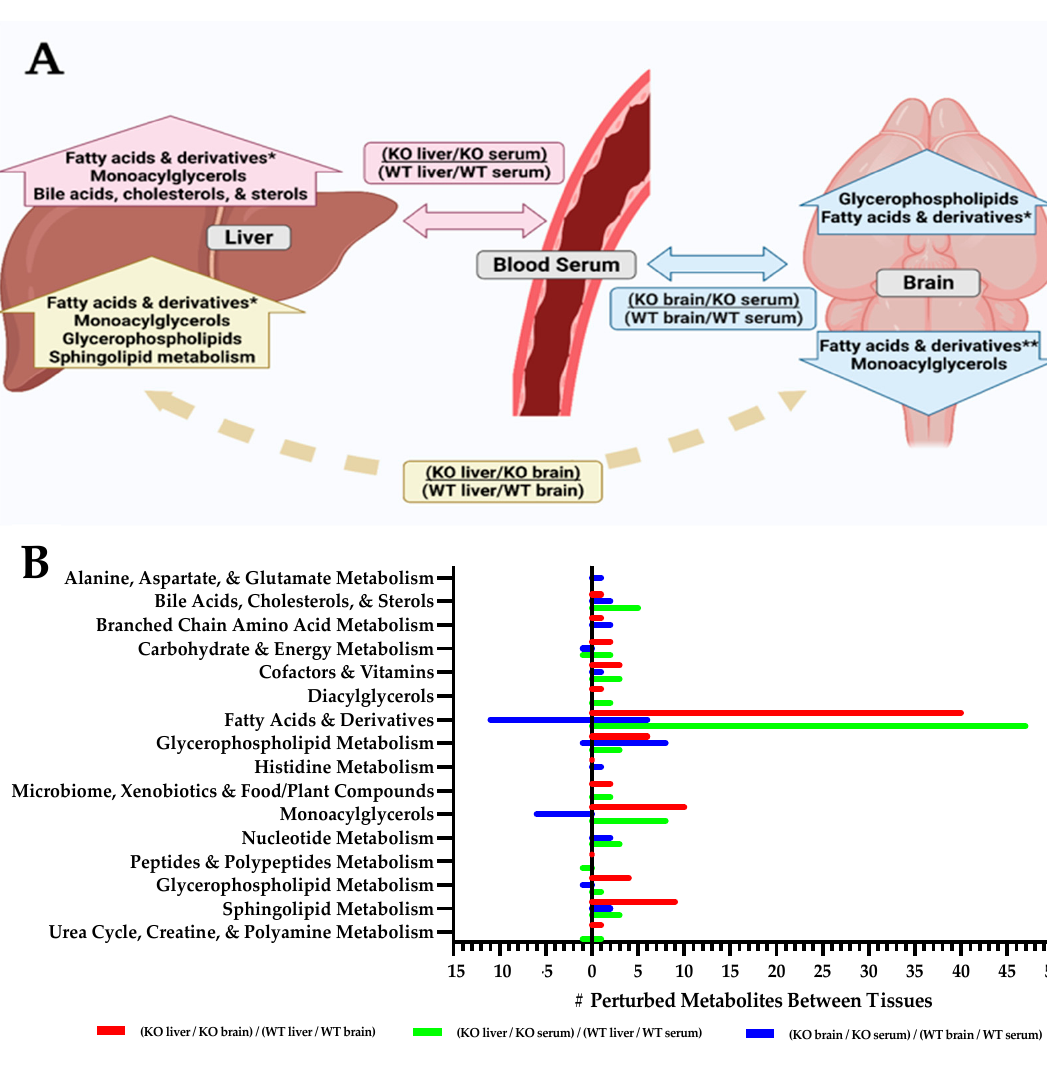
Figure 3. Metabolite flux between tissues is altered in Slc13a5 deficiency mice. ( A ) A model of the flow of metabolites between tissues in Slc13a5 − / − mice is shown. Horizontal arrows indicate the metabolite ratios assessed to understand the change in flux, storage, synthesis, or breakdown of metabolites between Slc13a5 − / − and WT mice. Mice included for each tissue type: serum (WT, n = 10; KO, n = 9), liver (WT, n = 10; KO, n = 10), or brain (WT, n = 10; KO, n = 9). Arrows pointing vertically represent types of metabolites whose proportional levels change between tissues in Slc13a5 − / − mice compared to WT mice. * = mix of short, medium, long, and very-long-chain fatty acids ** = only contain long (14–22 carbons) and very-long-chain (>22 carbons) fatty acids [27]. See Supplementary Data, Table S3. ( B ) Perturbed metabolite ratios between tissues and genotypes illustrating altered distribution. The numbers of molecules (#) in sub-pathways with ratios of <0.5 (left side of x -axis) and ratios of >1.5 (right side of x -axis) are represented. These altered ratios indicate that the proportionality of the metabolite between the two tissues of comparison is perturbed in the citrate transporter KO condition. The left side of the x -axis shows the numbers of molecules (#) in each sub-pathway with ratios of <0.5, indicating that in the KO, the metabolite is proportionally low in the numerator tissue. The right side of the x -axis shows the number of molecules (#) in each sub-pathway that had altered ratios between tissues that were >1.5 in the KO, indicating a higher proportional quantity of the metabolite in the numerator tissue compared to WT littermates. (see Supplementary Data, Table S4). Wildtype = WT; Knockout = KO. Detailed analysis of metabolites can be viewed in the interactive eTable 1: Slc13a5 eTable 1.